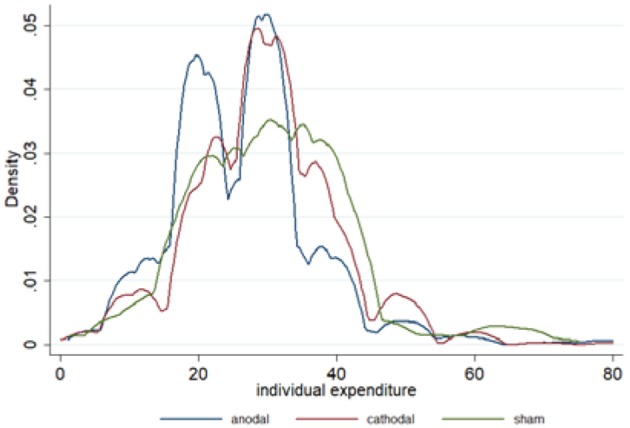
Kernel density comparison of the distribution of individual expenditures in the anodal, cathodal, and sham conditions across 20 periods. Kernel density estimates were computed using STATA 11.0 and Silverman bandwidth selection.